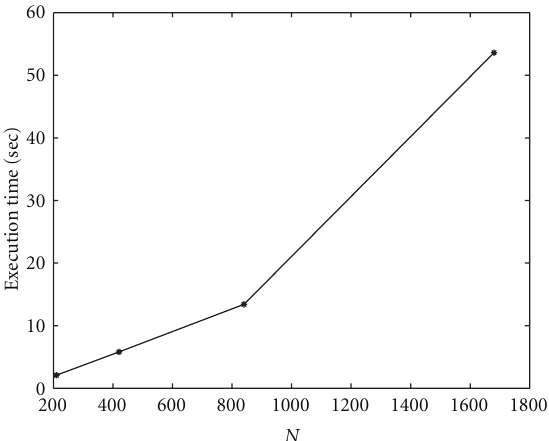
Figure 28: Scalability of parallel Algorithm SI, as N and p vary. Each point of the graph refers to the execution time of the parallel semi-implicit algorithm at ( p = k · p 1 , N = k · N 1 ), where p 1 = 1, N 1 = 210, and k = 1,2,3,4.